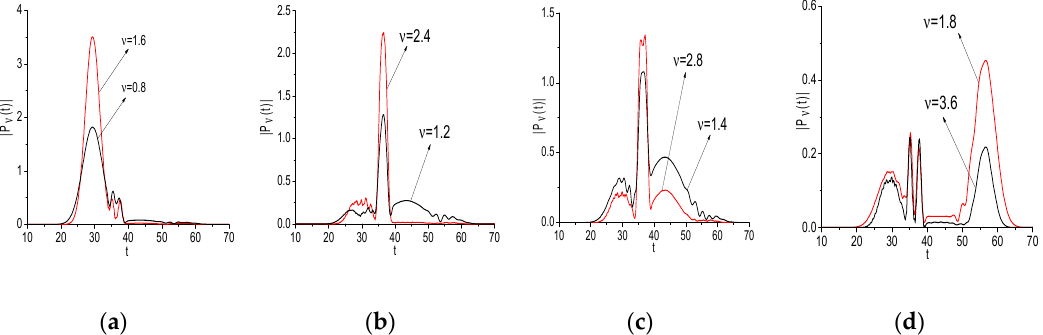
ν = 0.8, 1.2, 1.4, 1.8 base E t ), as inc